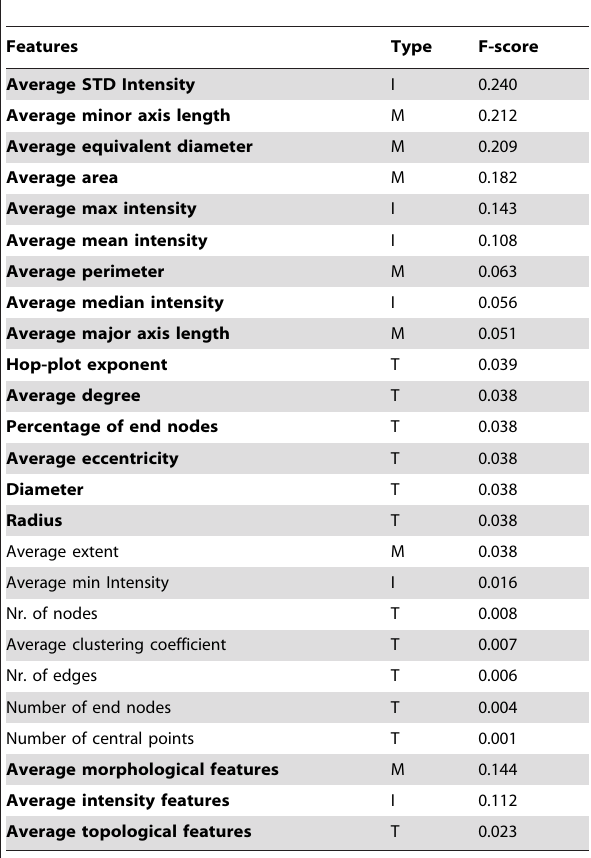
Table 3. The F-scores of each feature in descending order.